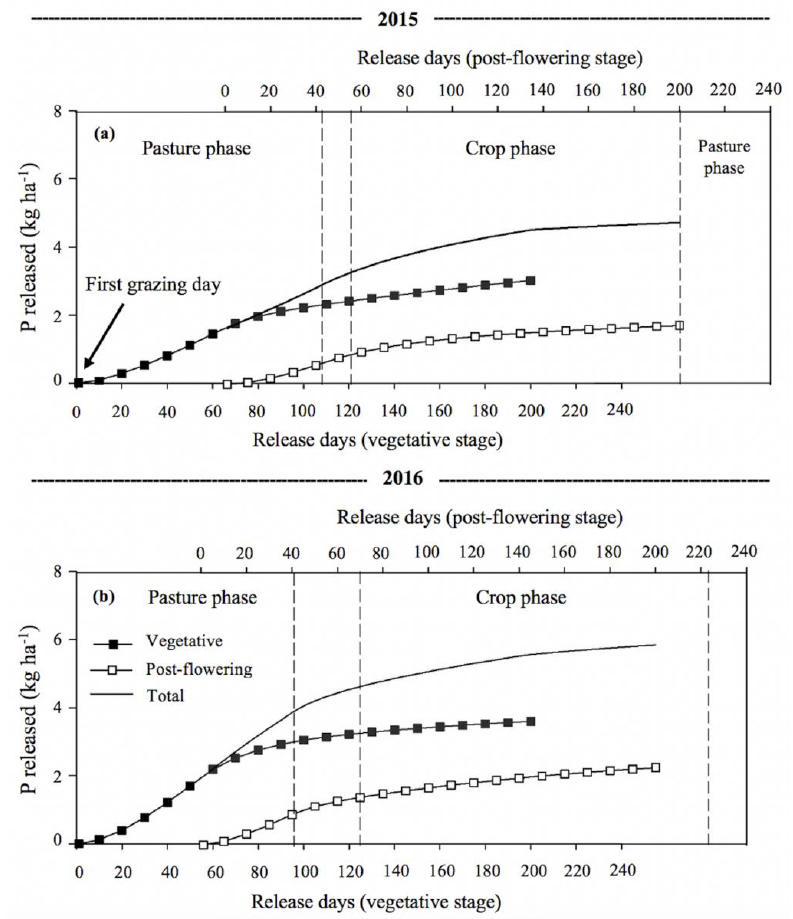
Figure 2. Accumulated phosphorus (P) release from sheep dung sampled at different pasture development stages (vegetative and post-flowering stages) and total accumulated P release over 2015 ( a ) and 2016 ( b ) annual cycles of a no-till integrated soybean-sheep production system (average of low and moderate grazing intensities). Table 4. Parameters of double exponential models fitted to phosphorus release rates from sheep dung, calculated half-life values (t 1/2 ), and coefficient of determination (R 2 ) at different decomposition phases during the 2015 and 2016 annual cycle of a no-till integrated soybean-sheep production system. Results are the averages of low and moderate grazing intensities.